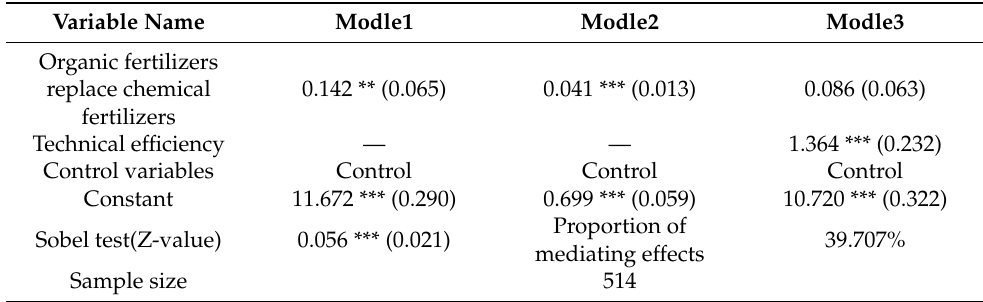
Table 12. Sobel mediation effect test for farmers’ technical